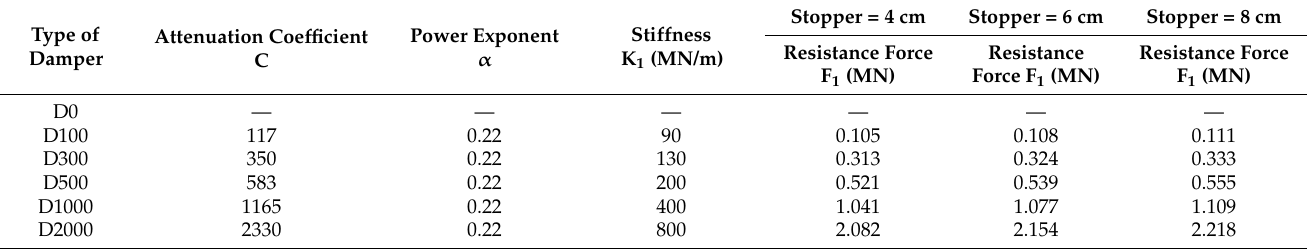
Table 2. Structural properties of viscous dampers.